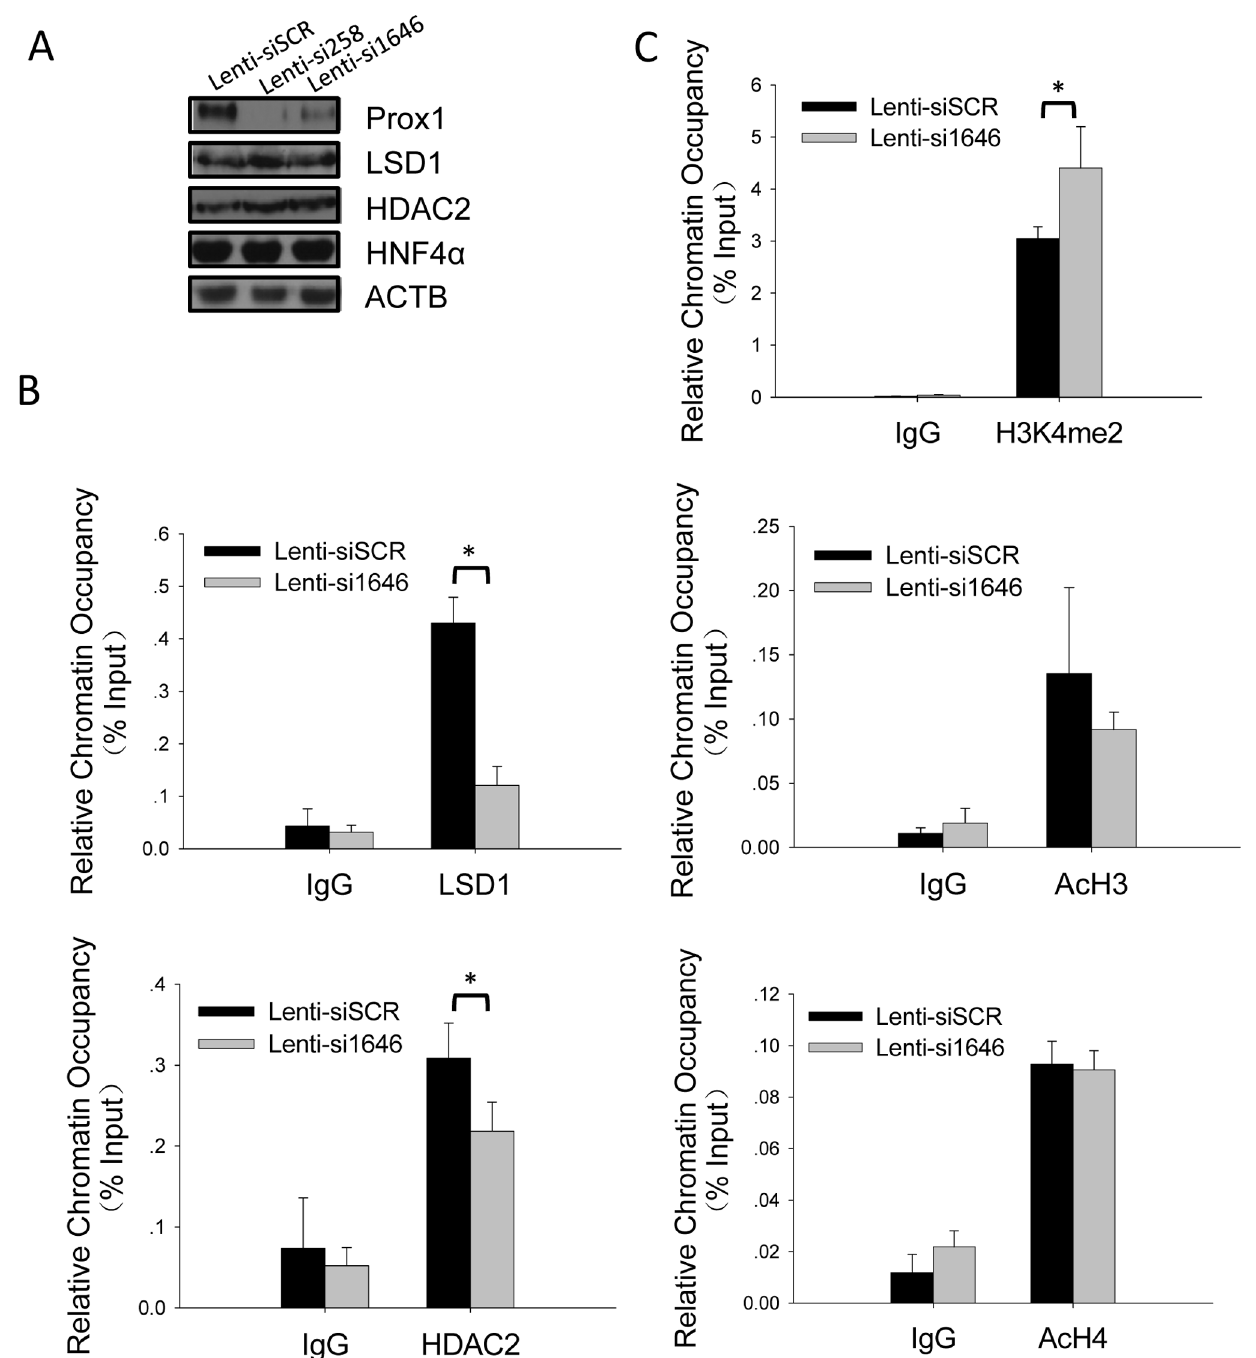
Figure 4. Prox1 recruits LSD1/NuRD complex components to CYP7A1 promoter and engenders repressive epigenetic changes in histone modification patterns. (A) Expression levels of LSD1/NuRD complex components LSD1 and HDAC2 in HepG2 are not affected by Prox1. HepG2 cells were infected with recombinant lentiviruses expressing Prox1-targeting siRNA precursors si258 or si1646, or scrambled control siSCR as indicated and protein levels of Prox1, HNF4 a , LSD1 and HDAC2 were detected in Western blot 36 hours post infection. Beta-actin was used as loading control. (B) Knockdown of Prox1 decreases LSD1 and HDAC2 occupancy on CYP7A1 promoter. HepG2 cells infected with indicated recombinant lentiviruses were subjected to ChIP analysis using antibodies to LSD1 and HDAC2, respectively. (C) Knockdown of Prox1 increases the level of H3K4 methylation on CYP7A1 promoter. HepG2 cells infected with indicated recombinant lentiviruses were subjected to ChIP analysis using antibodies to di-methylated H3K4 (H3K4me2), acetylated H3 and acetylated H4, respectively. Precipitated CYP7A1 promoter segments in B and C were detected using quantitative real-time PCR and relative chromatin occupancy was calculated as %input as described in Materials and Methods. Normal mouse/ rabbit IgG was used as non-specific control. Means and SD from three independent experiments are presented. Statistically significant changes ( P , 0.05 in student’s t test) were indicated (*). Results similar to B and C were obtained using lenti-si258 infection (Supplementary Figure S1).